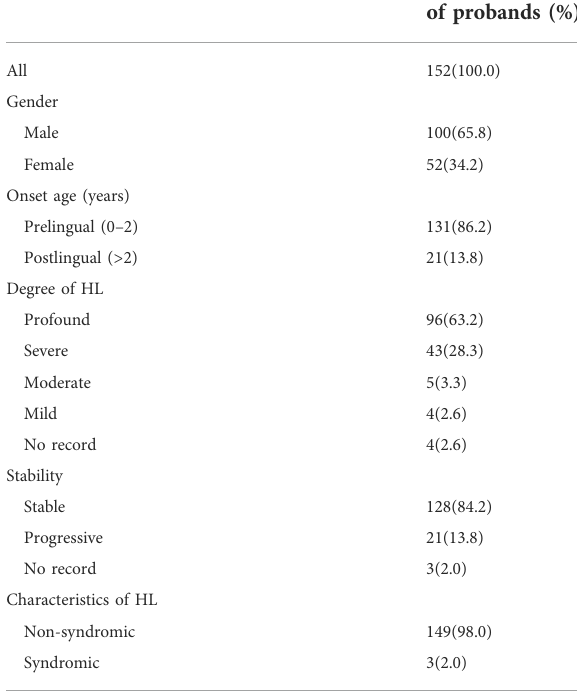
TABLE 1 Clinical features of the